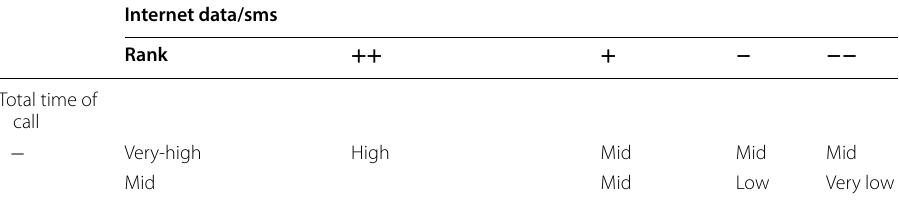
Table 11 TFM score for the total call durations and the total amount of Internet data/sms with multi‑level